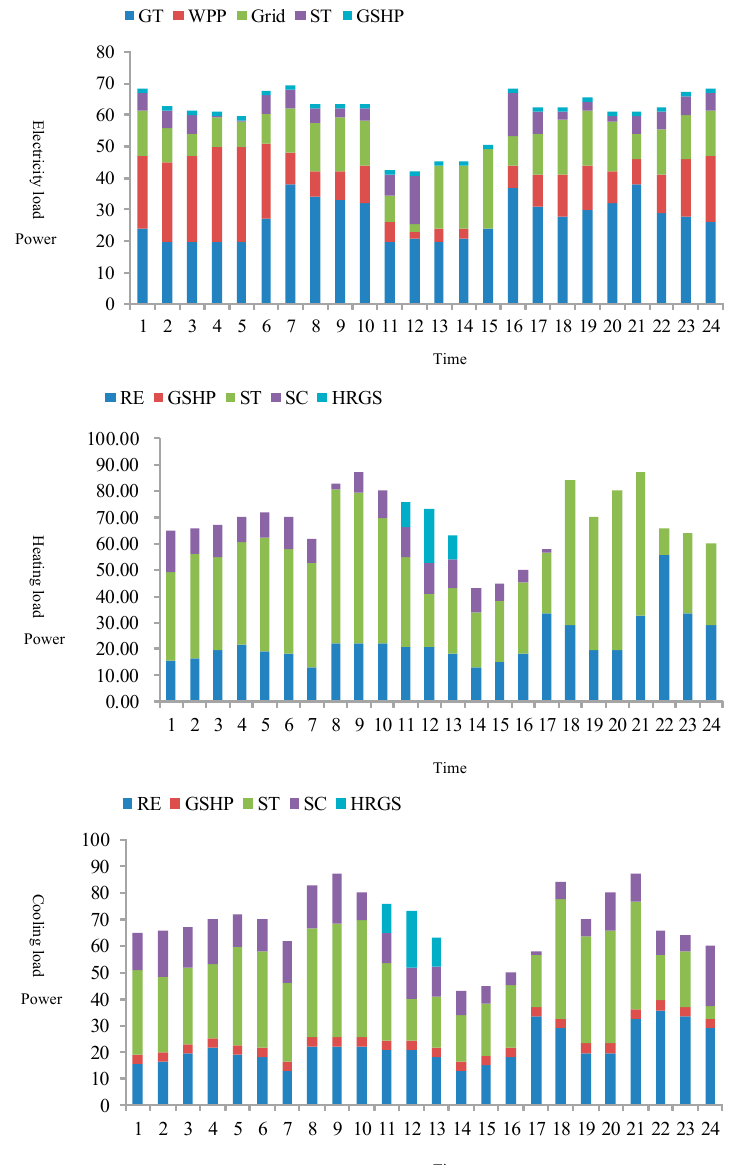
Figure 5. Hourly electric, heating, and cooling load supply of scenario 1 (unit: MW).